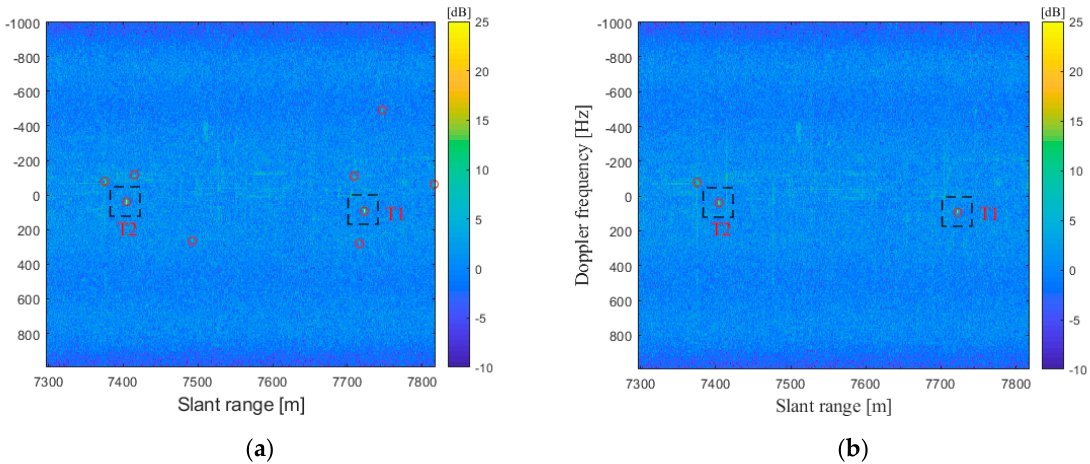
Figure 11. Range − Doppler image of the moving target detection: ( a ) amplitude detector; ( b ) phase detector with amplitude assistance.